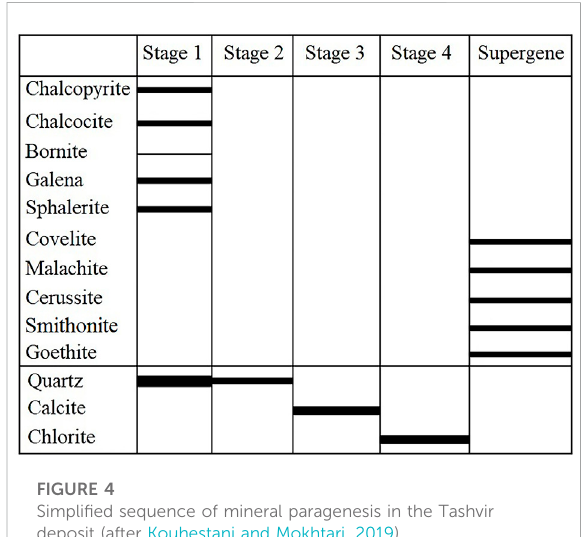
FIGURE 4 Simpli fi ed sequence of mineral paragenesis in the Tashvir deposit (after Kouhestani and Mokhtari, 2019).